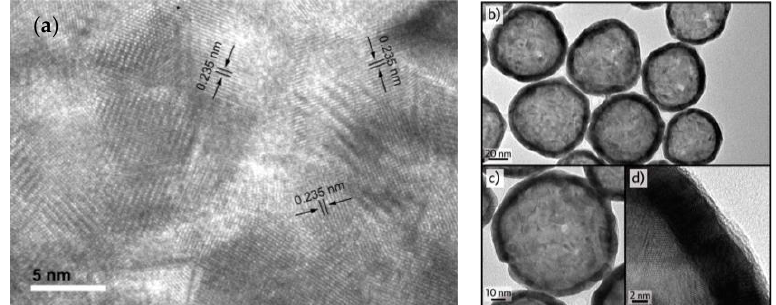
Figure 11. High resolution TEM images: ( a ) Depicting crystalline structure of gold nanoshells. Reprinted with permission from Reference [64]. Copyright (2005) American Chemical Society; ( b – d ) at various magnifications that detail hollow core (light) and shell structure (dark) Reprinted with permission from Reference [70]. Copyright (2014) American Chemical Society.